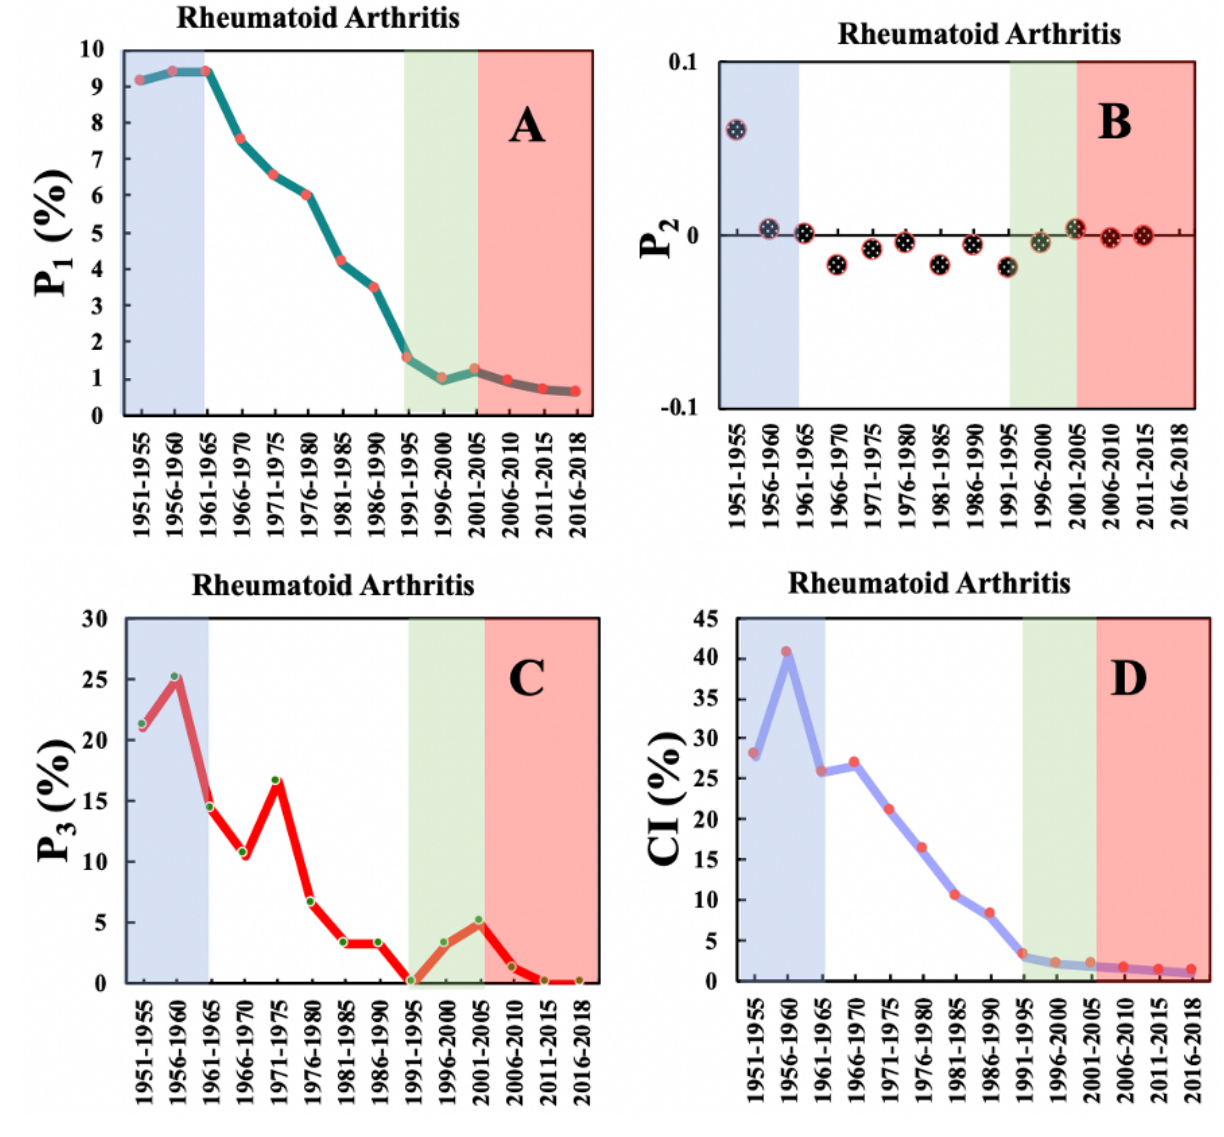
Figure 2. The 4 entitymetric indexes of the biomedical entity “Rheumatoid Arthritis” over time. The background colors indicate the 4 phases of aspirin